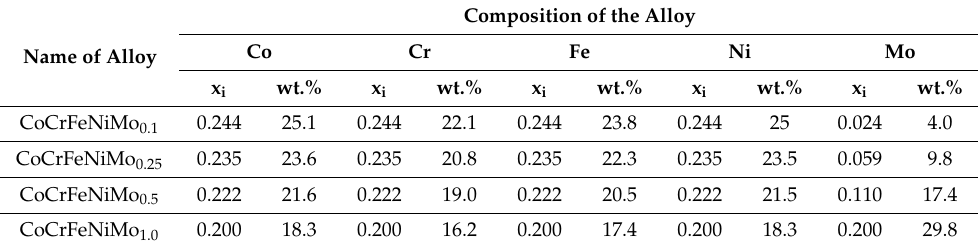
Table 1. Composition of selected